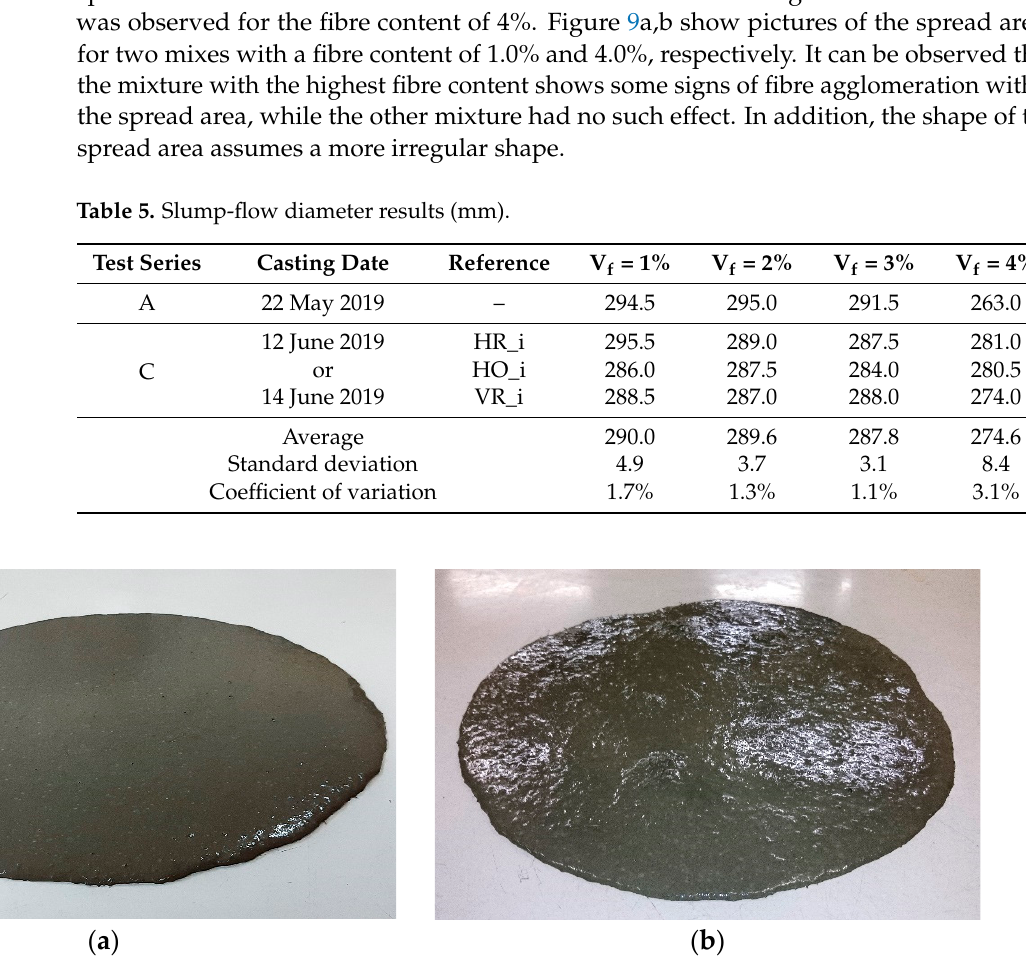
( b ) Figure 10. Variation of ( a ) μ r and ( b ) (ρ (cid:2908) − ρ (cid:2909) ) with the measuring direction (specimens with h U = 100 mm). Figure 11a shows the variation of the mean relative magnetic permeability for all four specimens as a function of the specimen’s thickness. μ r,mean decreases with the thickness of